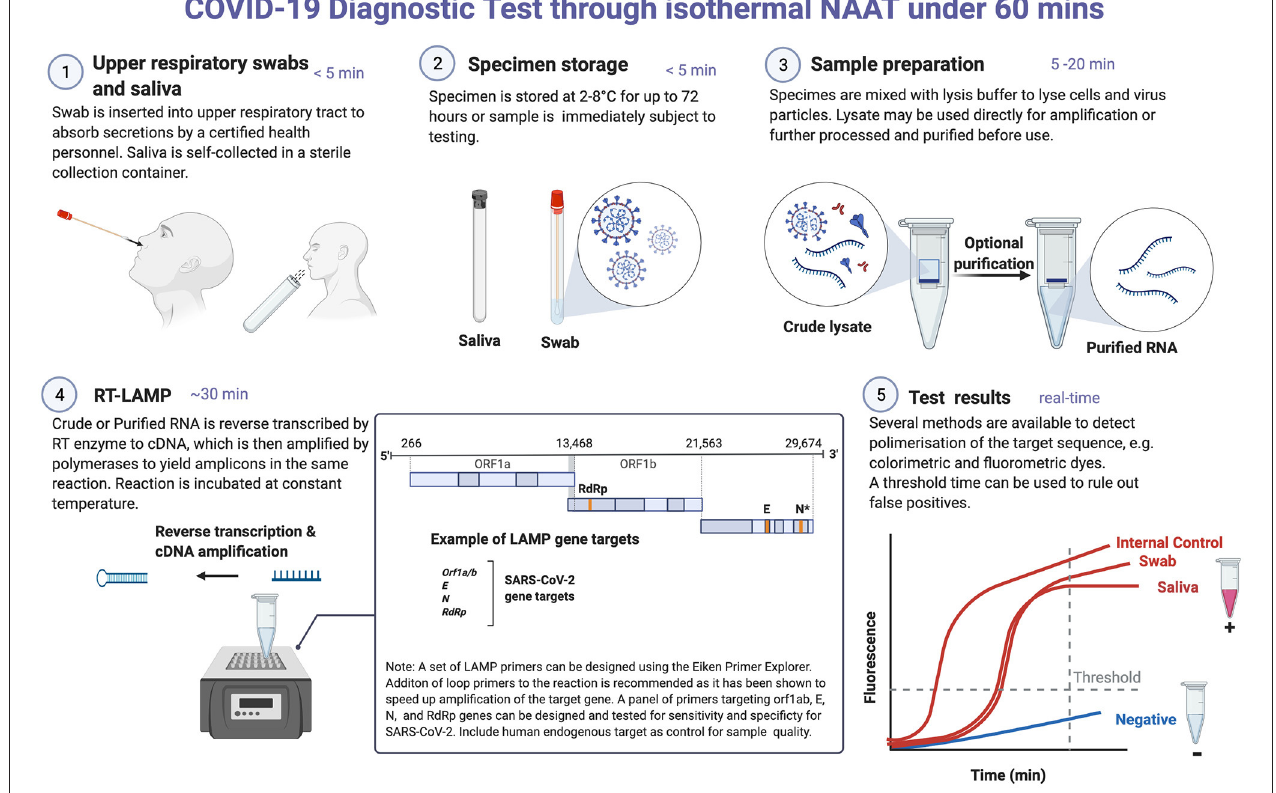
FIGURE 1 | COVID-19 diagnostic testing through isothermal NAAT. Reverse transcriptase LAMP (RT-LAMP) detection of SARS-CoV-2 RNA in nasal swab and saliva samples. These samples can be stored in the refrigerator for 3 days prior to NAAT testing. Where testing can be done immediately, sample preparation and/or RNA extraction is performed, which may take between 5 and 20min. RNA purification is often required for RT-PCR-based testing. This is done because contaminants in crude cell lysates could potentially reduce the polymerase activity of the reverse transcriptase and DNA polymerases used in RT-PCR. In contrast, the Bacillus stearothermophilus (Bst) DNA polymerase used in LAMP is more tolerant to inhibitors. For RT-LAMP testing, a set of four to six primers targeting any of the viral genes can be designed using online programs, e.g., Eiken Primer design software. It is recommended that a primer set targeting a human endogenous gene is included as a control for sample preparation/RNA extraction and amplification efficiency. In RT-LAMP, both cDNA synthesis (reverse transcriptase) and amplification (Bst) occur simultaneously and in the same reaction tube at a constant temperature (60–65 ◦ C). A double-stranded DNA intercalating dye can be added to detect amplicons either by colorimetry (show color change), fluorescent (for real-time detection) or both. RT-LAMP is prone to false-positive amplifications and as such any assay developed using this technique needs to be standardized for each test type. *In a NAAT-based assay, two targets on N gene were included in a single reaction to increase the test sensitivity. Created with